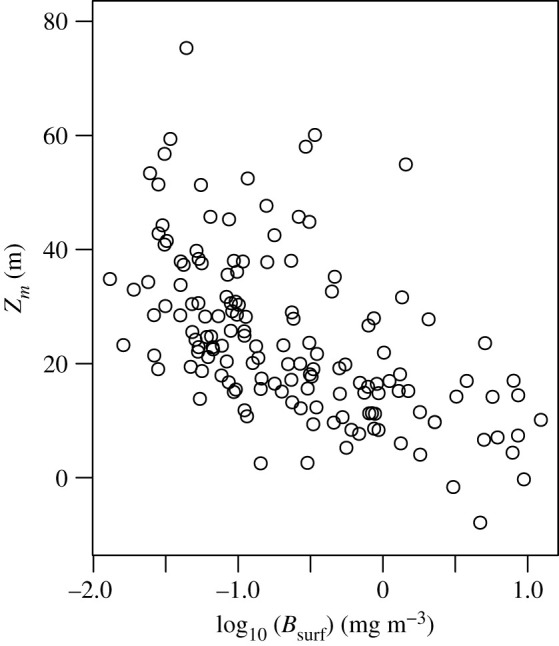
Relationship between surface chlorophyll concentration (Bsurf) and the depth of the subsurface chlorophyll maximum (zm) (R2 = 0.14, p < 0.001).